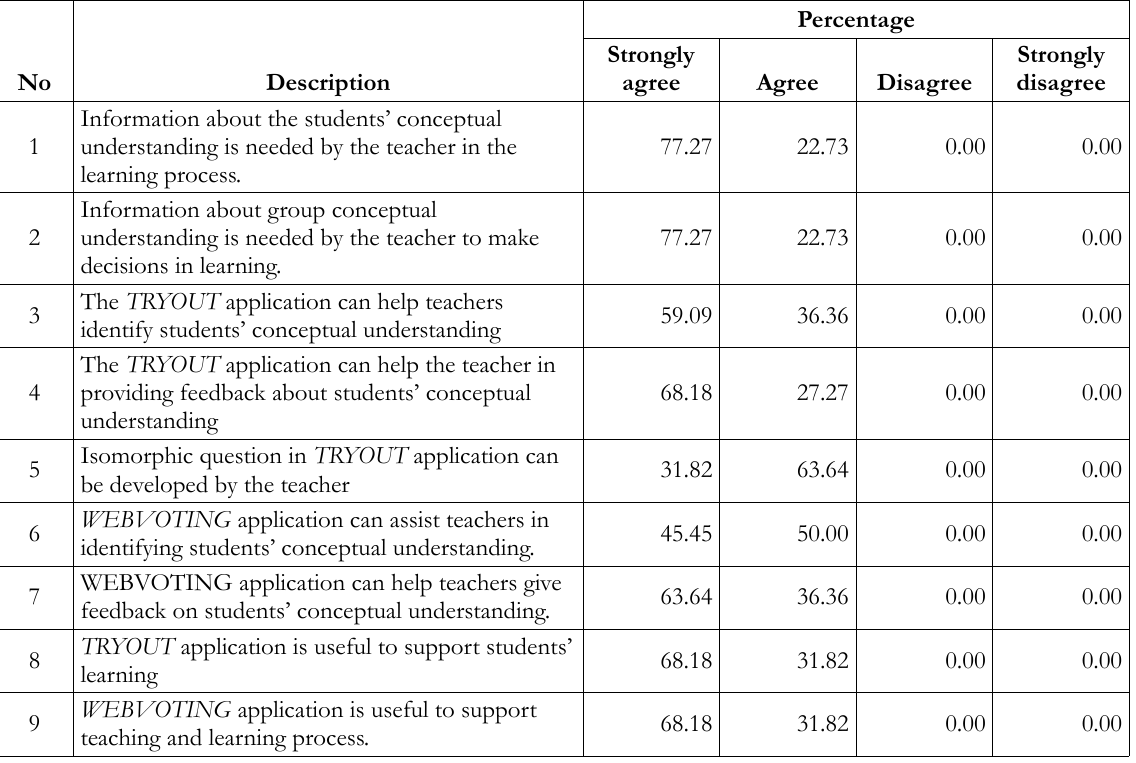
Table 1. Secondary physics teacher’s perception about Tryout and Webvoting